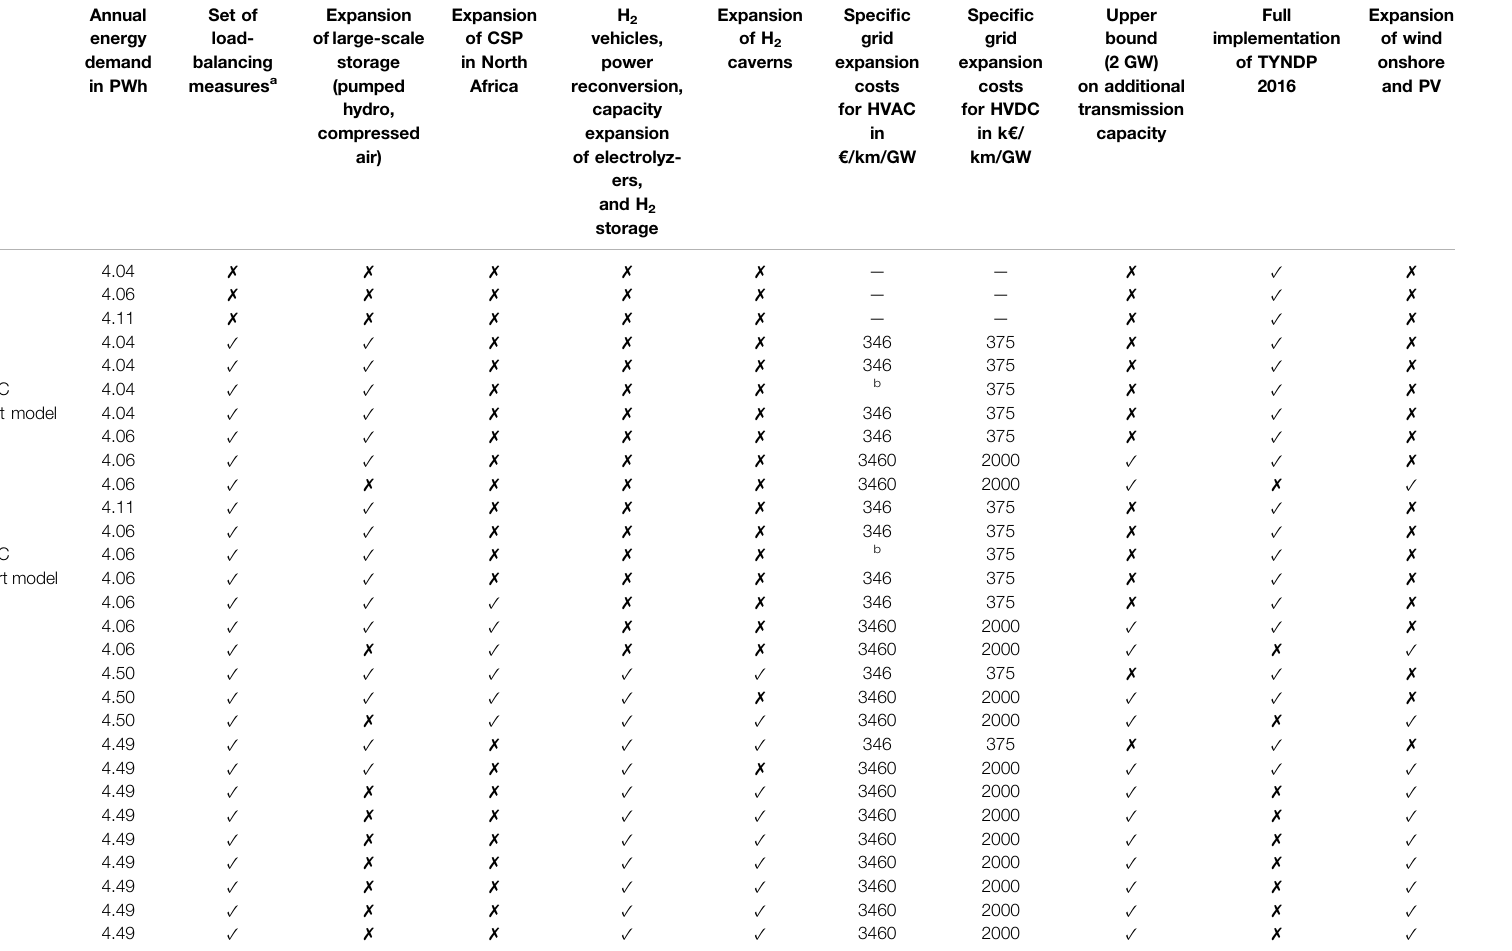
TABLE 3 | Speci fi cation of scenarios and model